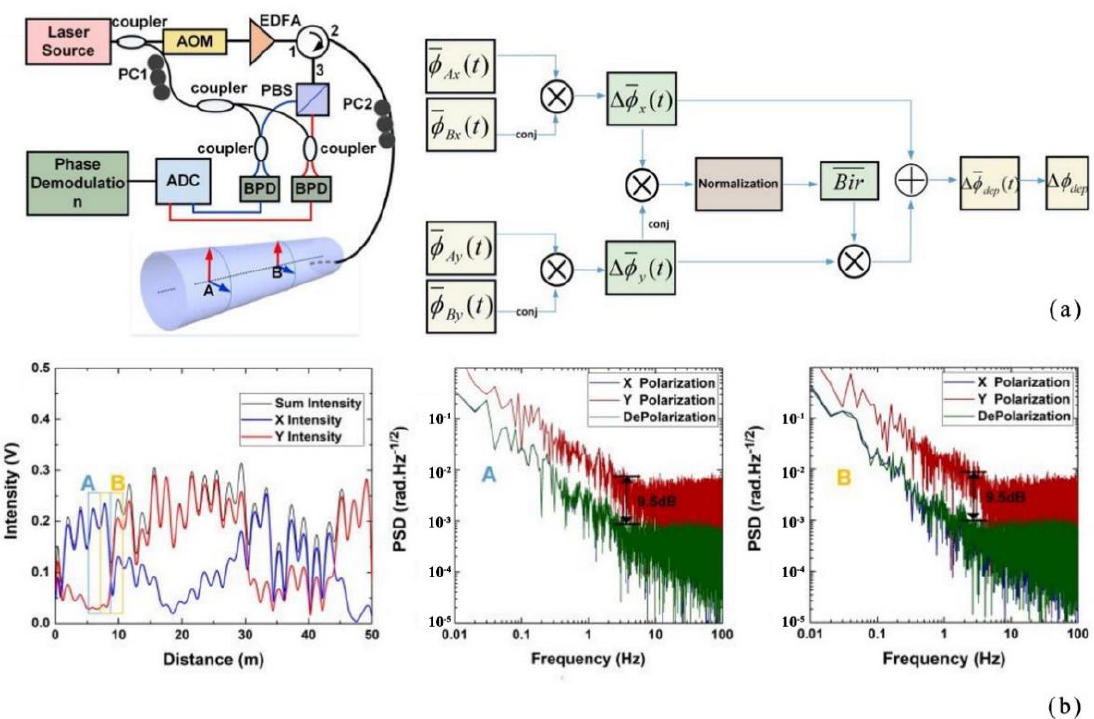
Figure 5. ( a ) Experimental setup and demodulation procedure. ( b ) Backscattered light intensity of backscattering enhanced fiber in different polarized states; PSD of fiber section A; PSD of fiber section B in X polarized state, Y polarized state and depolarized algorithm. [33].